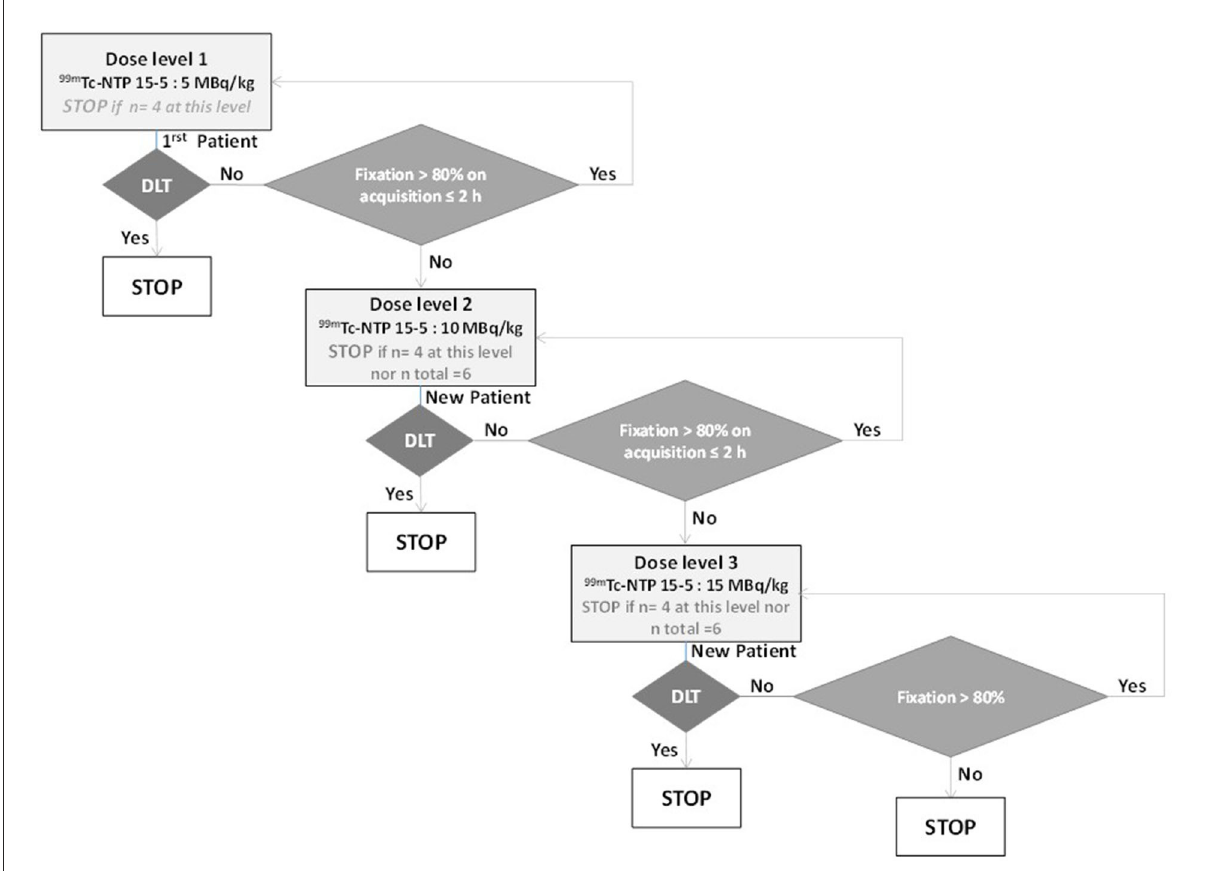
FIGURE1 Dose escalation plan of CARSPECT